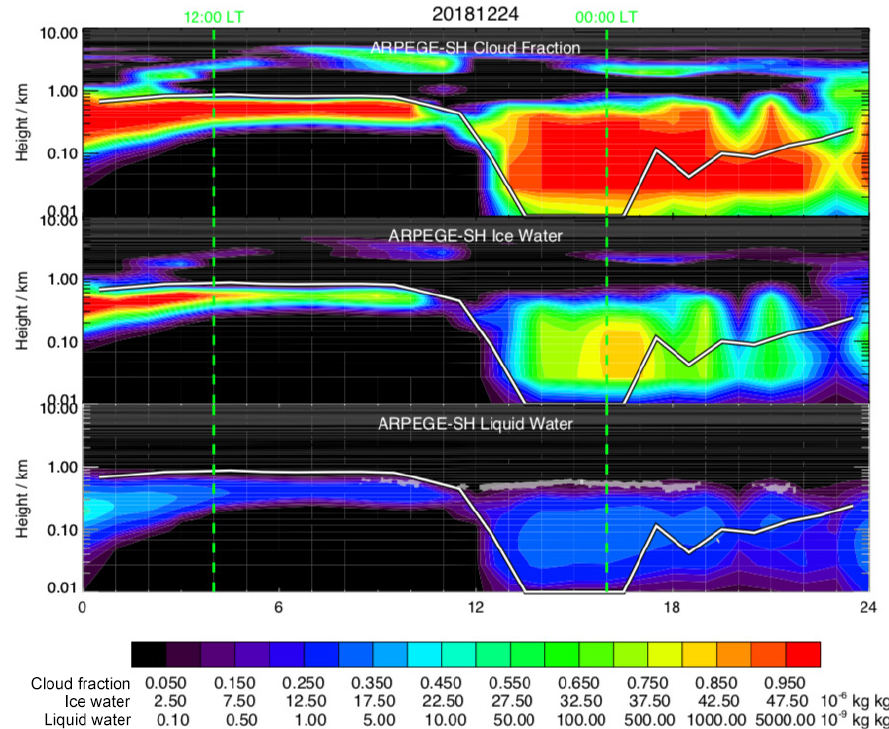
Figure 3. Time–height cross section on 24 December 2018 (UTC time) of (a) the cloud fraction (0–1), (b) the ice water mixing ratio (10 − 6 kgkg − 1 ), and (c) the liquid water mixing ratio (10 − 9 kgkg − 1 ) calculated by the ARPEGE-SH model. Superimposed on all the panels is the top of the planetary boundary layer calculated by the ARPEGE-SH model (black–white thick line). Superimposed on panel (c) is the SLW cloud (grey area) deduced from the lidar observations (see Fig. 1c). Two vertical green dashed lines indicate 12:00 and